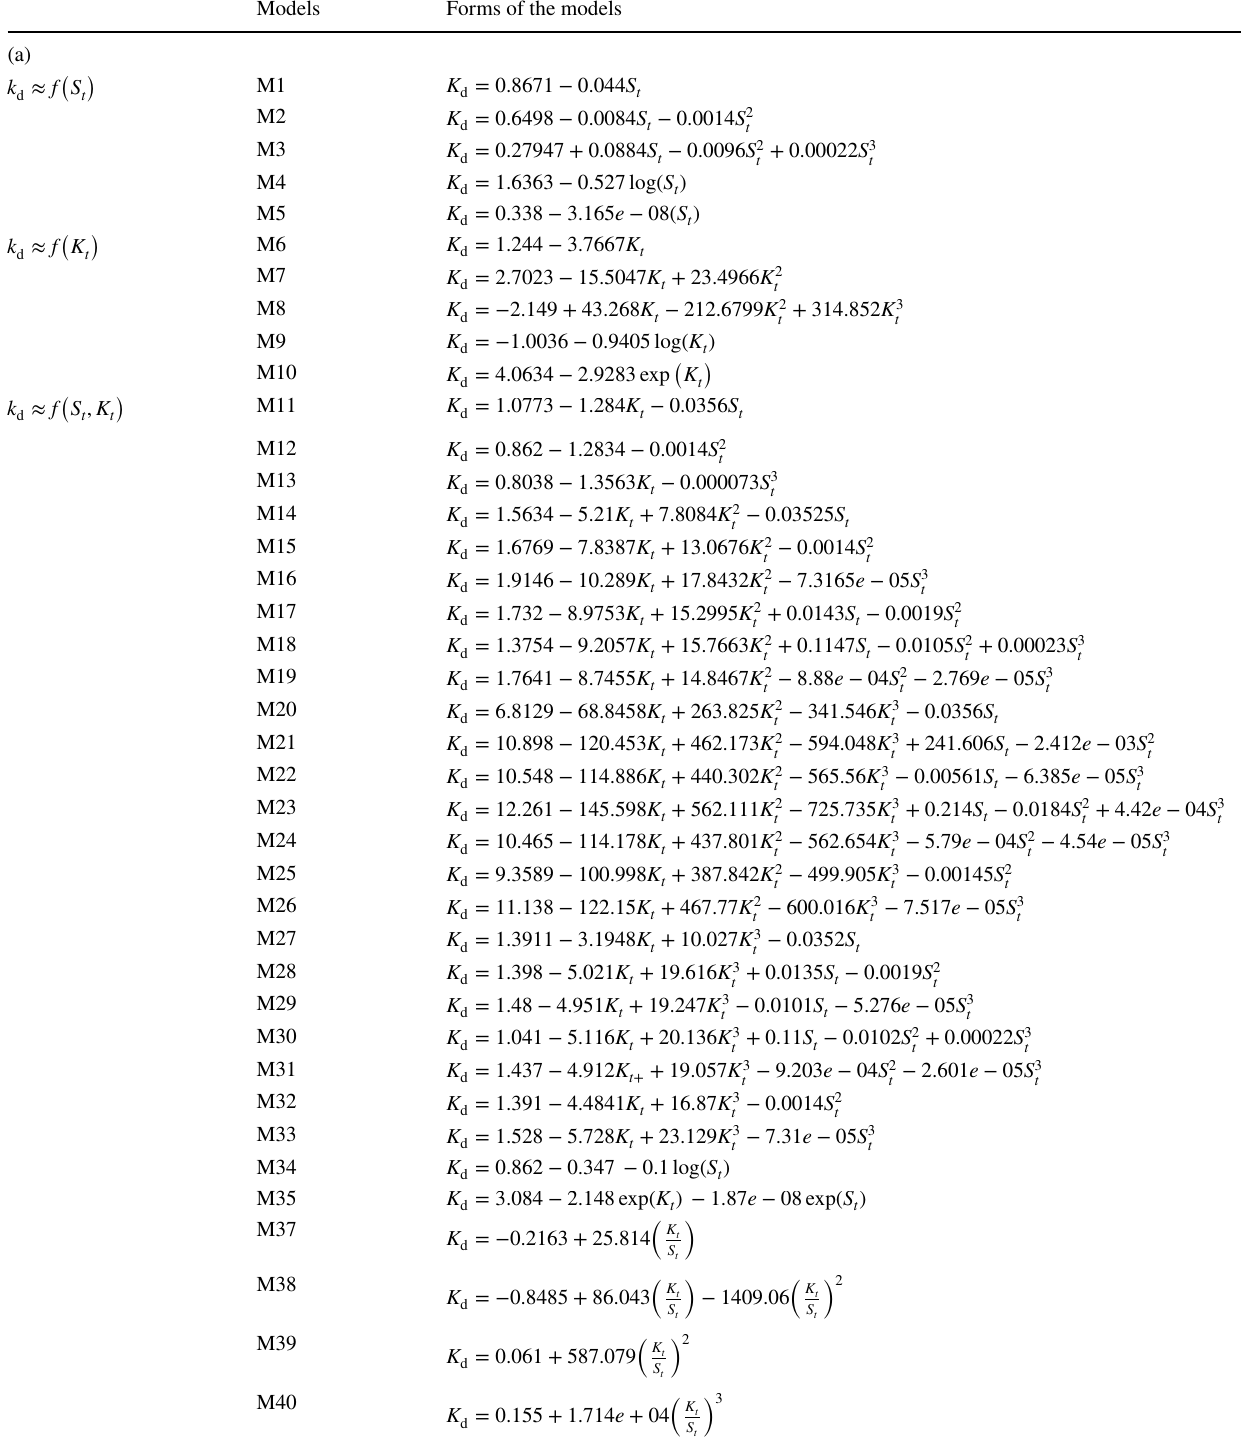
Table 2 (a) Various forms of correlations for diffuse fraction and (b) various forms of correlations for diffusion coefficient Models Forms of the